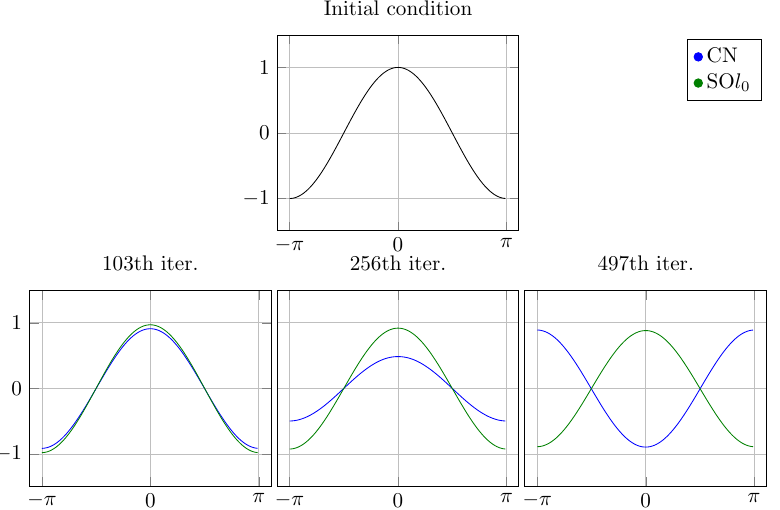
Figure 6. ( Top row ) Cosine initial condition. ( Bottom row ) We plotted the solution from our academic setting at different iterations. The solution was generated using the SO l 0 (green) scheme and the CN (blue) method. We chose iterations close to 100, 250 and 500 at which the SO l 0 solution has a maximum amplitude. We notice a phase drift and small damping as well. For faster results, we increased the time increment to τ =